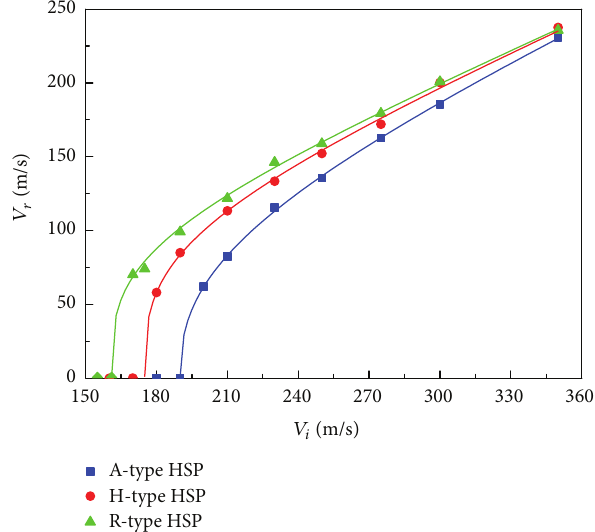
Figure 5: Residual velocity versus impact velocity of projectile for three types of